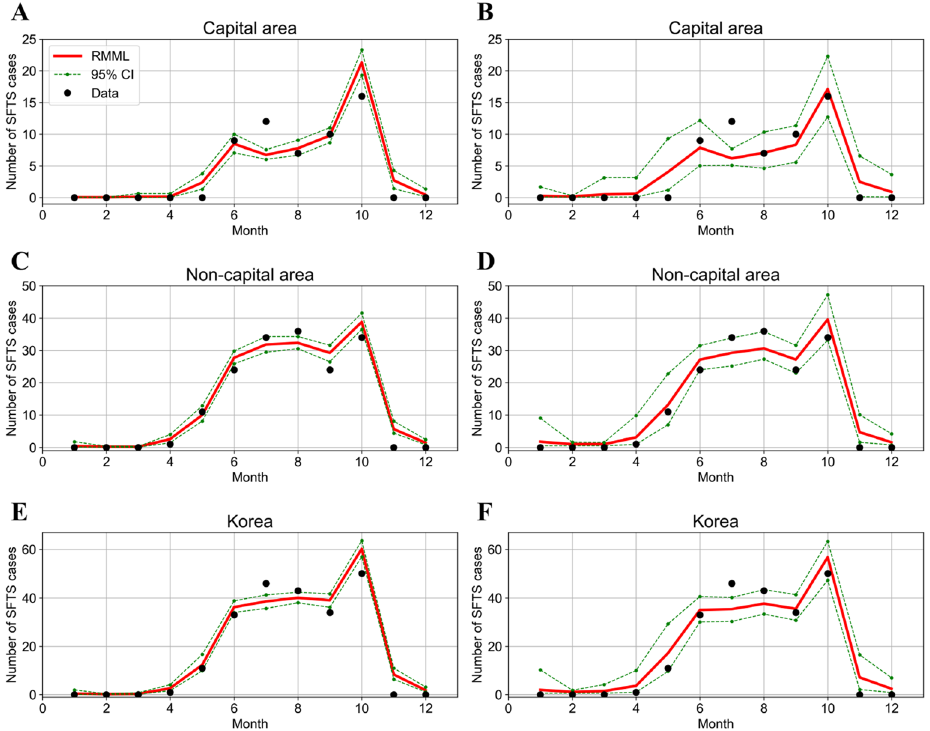
Figure 3. Comparison of observed cases and estimated values of the number of severe fever with thrombocytopenia syndrome (SFTS) cases. In ( A – B ), capital area; ( C – D ), non-capital area; and ( E – F ), Korea. The black dots represent the observed cases, and the red solid lines indicate the estimated values of SFTS cases with 95% confidence intervals shown in green dashed lines. Gradient boosting was employed in ( A , C , and E ), and the bagging tree method was used in ( B , D , and F ).